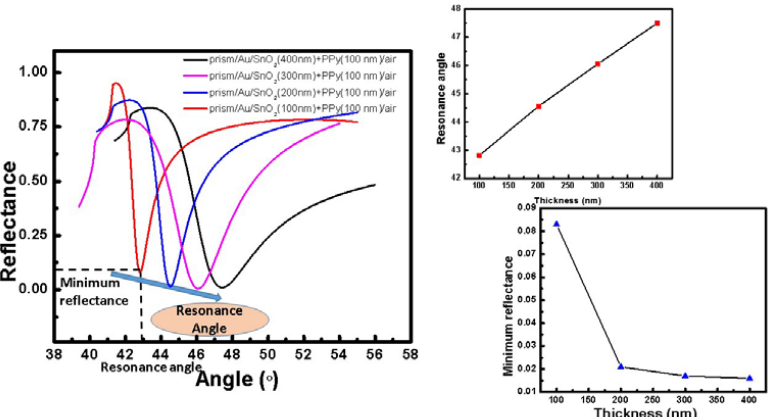
Figure 2. (Prism + Au + SnO 2 + PPy + air) Multilayered systems’ Theoretically simulated SPR reflectance curves by varying the thickness of SnO 2 and variation of resonance angle and minimum reflectance with the thickness of SnO 2 .